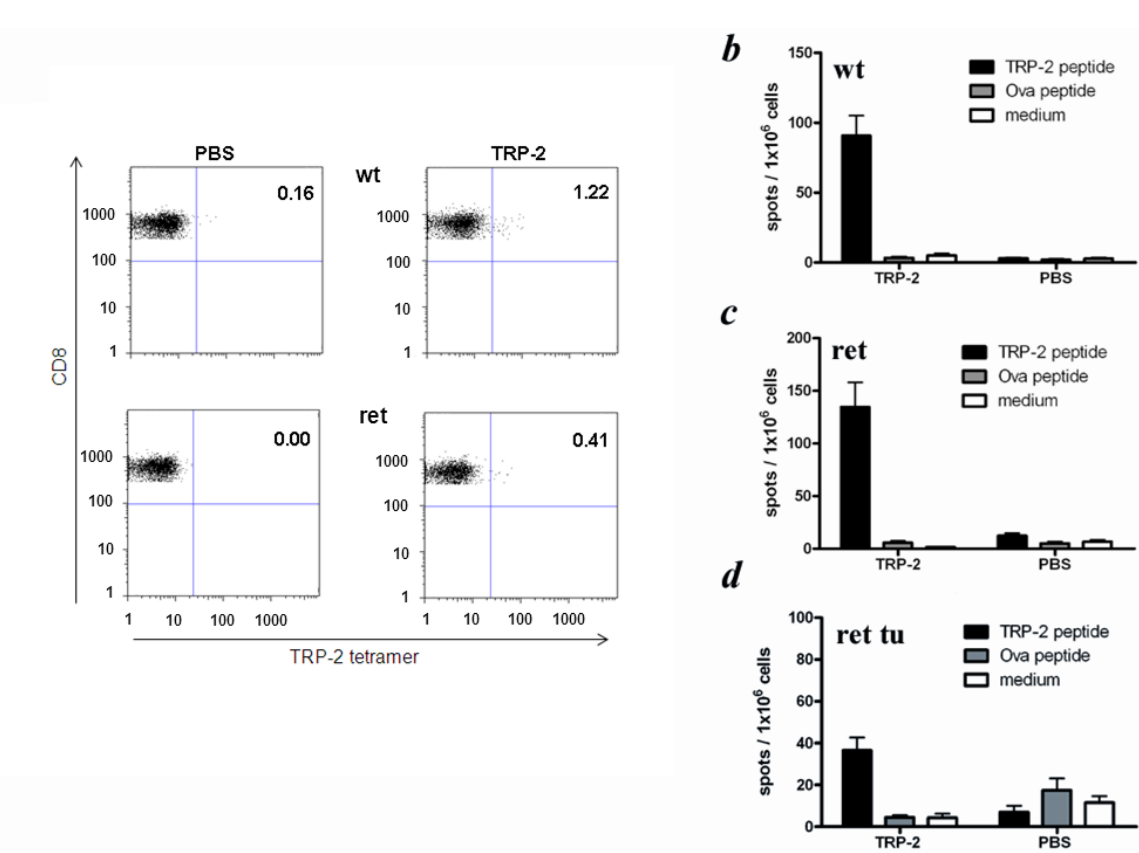
Figure 5. Induction of TRP-2-specific CD8 + T cell responses in ret transgenic mice. Mice with (ret tu) or without macroscopic tumors (ret) or non-transgenic littermates (wt) were immunized with the peptide derived from TRP-2. Frequencies and functional activities of TRP-2-specific spleen CD8 + T cells were analyzed ex vivo by tetramer staining ( a ) and IFN- γ ELISPOT assay ( b–d ). Control animals were injected with PBS. ( a ) Representative dot plots for tetramer staining are shown; ( b–d ) Cumulative data (mean ± SEM; 6–8 mice per group) for IFN- γ secreting CD8 + T cells are shown as numbers of IFN- γ spots among 1 × 10 6